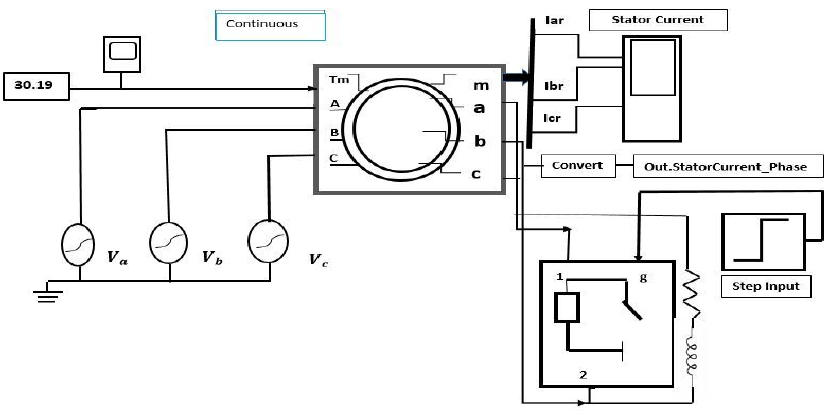
Energies 2022 , 15 , x FOR PEER REVIEW Figure 2. Rotor bar fault in MATLAB Simulink Environment A-C stator phases and a-c rotor phases. Figure 2. Rotor bar fault in MATLAB Simulink Environment A-C stator phases and a-c rotor phases. Figure 2. Rotor bar fault in MATLAB Simulink Environment A–C stator phases and a–c rotor phases.